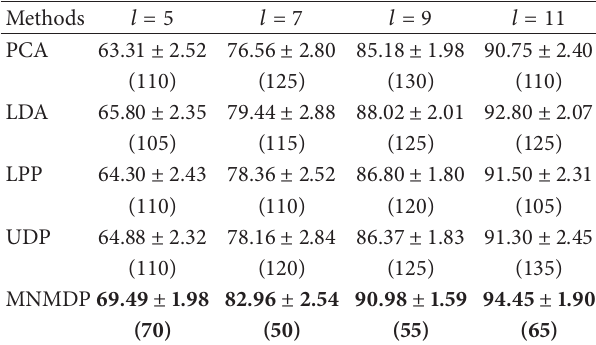
Table 2: The maximal average recognition rates (%) of each method on FKP with the corresponding standard deviations (stds) and values of dimension in the